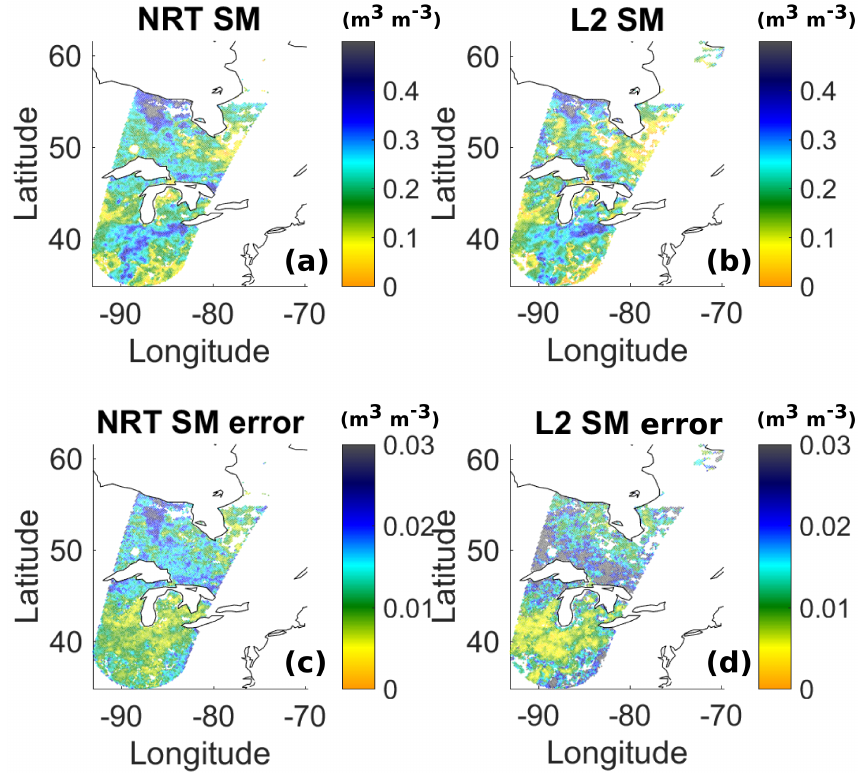
Figure 1. Comparison of the NRT SM NN product (a) and the Level 2 SM (b) for one orbit of 27 May 2012. The corresponding NRT SM uncertainty is shown in (c) , while the L2 SM uncertainty is shown in (d)